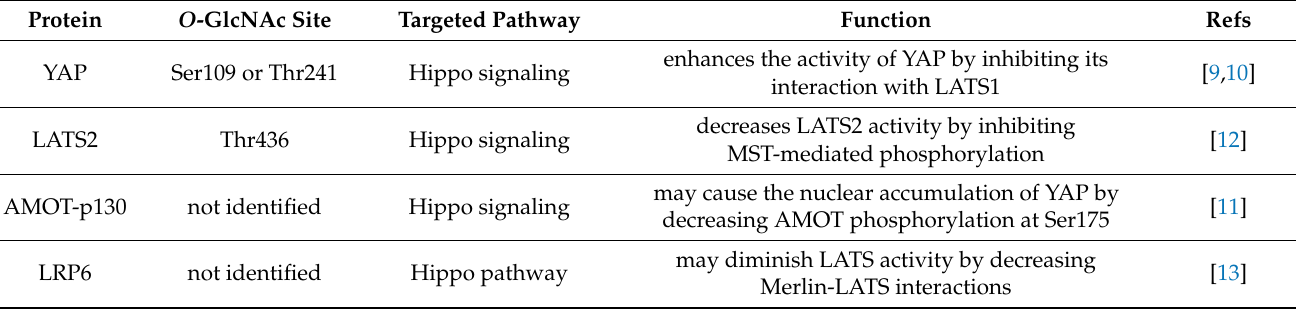
Figure 5. The schematic model of O -GlcNAcylation regulating the Hippo pathway through other pathways that crosstalk with the Hippo pathway. The O -GlcNAcylation of β -catenin, a mediator of the canonical Wnt signaling pathway, competes with ubiquitinylation-inducing β -catenin phosphorylation, which may stabilize β -catenin and TAZ and promote β -catenin/TCF4 complex-mediated YAP expression. Smad4 O -GlcNAcylation enhances the TGF- β /SMAD signaling pathway, which can upregulate SnoN gene expression, thereby inactivating LATS1/2 by stabilizing Smad4. PKC O -GlcNAcylation is possibly related to TGF- β signaling in a way that TGF β RII expression is decreased by reducing PKC activities. In G α s-coupled GPCR signaling, PKA O -GlcNAcylation may enhance LATS1/2 activity by increasing PKA-mediated LATS1/2 phosphorylation or inhibiting actin fiber formation. NOTCH1 O -GlcNAcylation elicits the release of NICD, which can stabilize YAP/TAZ, by enhancing the interaction between NOTCH1 and DLL1 or DLL4. Table 1. Summary of the O -GlcNAc proteins involved in the Hippo pathway and the action mode of O